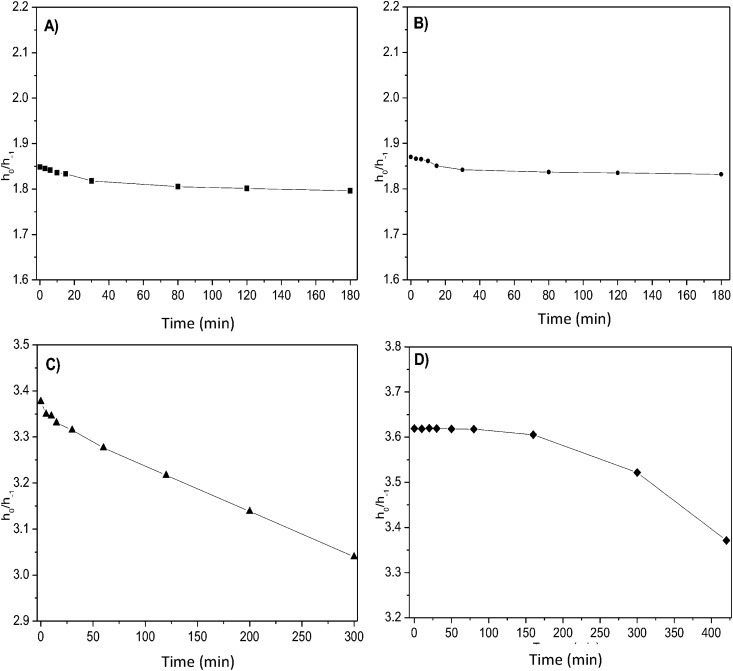
Kinetics of ACE-catalyzed hydrolysis of TOAC0-AngI (A), TOAC1-AngI (B), TOAC3-AngI (C), and TOAC5-AngI (D) monitored by the variation of the h0/h-1 values in the peptides EPR spectra as a function of time.